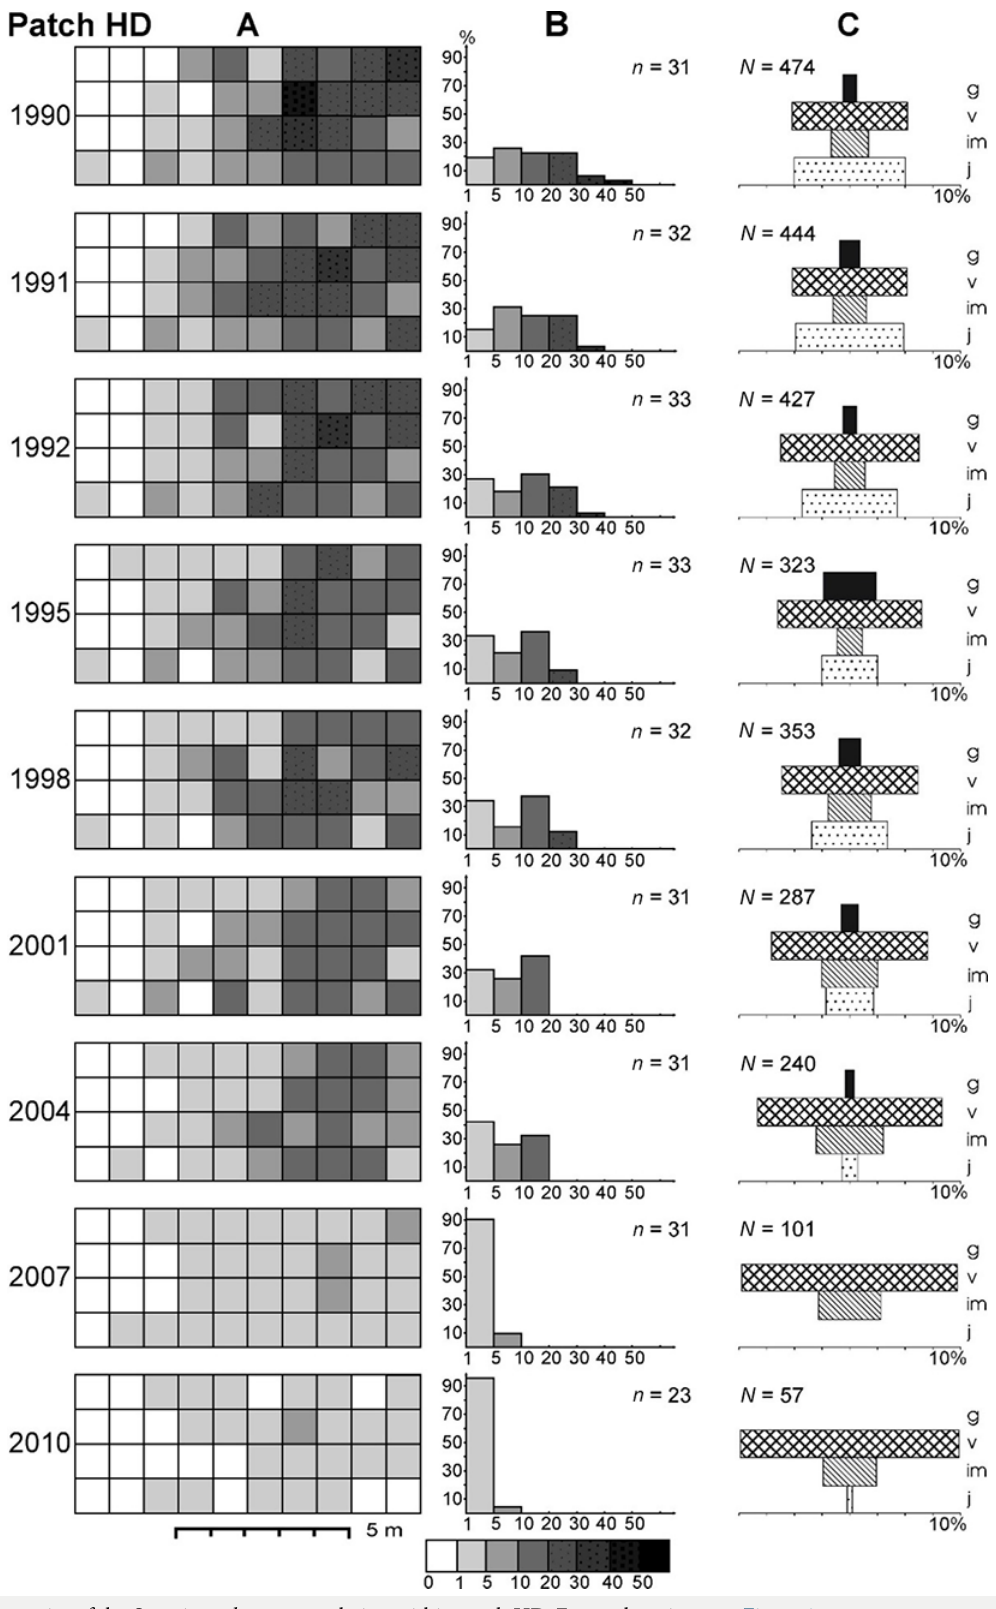
Figure 4 Dynamics of the Senecio umbrosus population within patch HD. For explanations see Figure 2.